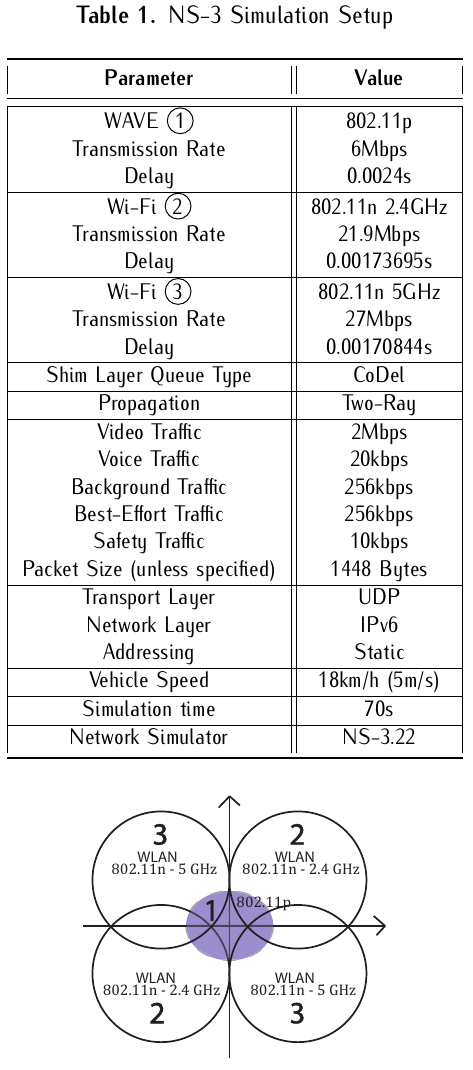
Figure 7. Simulation